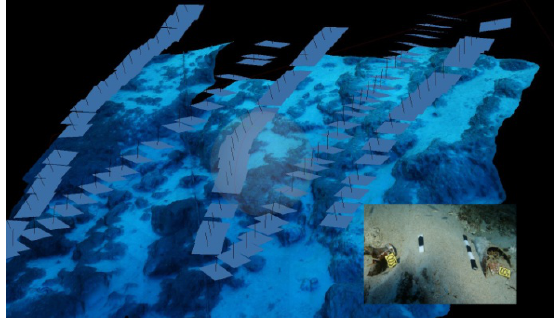
Figure 9: 3D shaded model, flight plan and image detail of wreck No.26, © H.I.M.A., E.